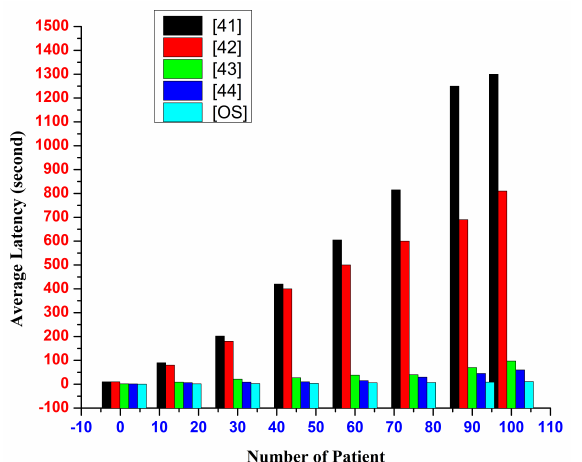
Figure 5. Number of patient requests and response latency in hospital center [41–44].